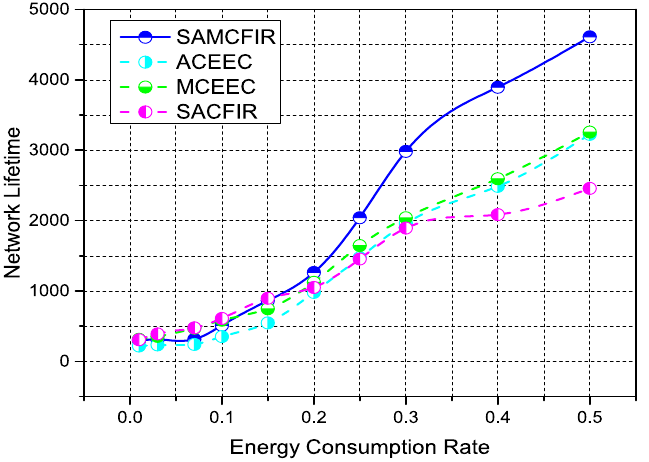
Figure 13. Energy consumption rate as network operation progress in network of 450 m × 450 m with 300